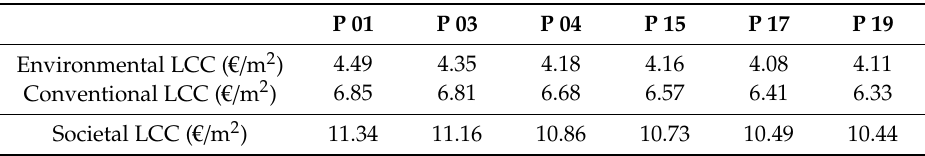
Table 4. Societal LCC for 1 m 2 of ceramic